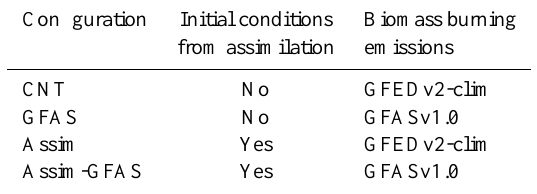
Table 2. Definition of model